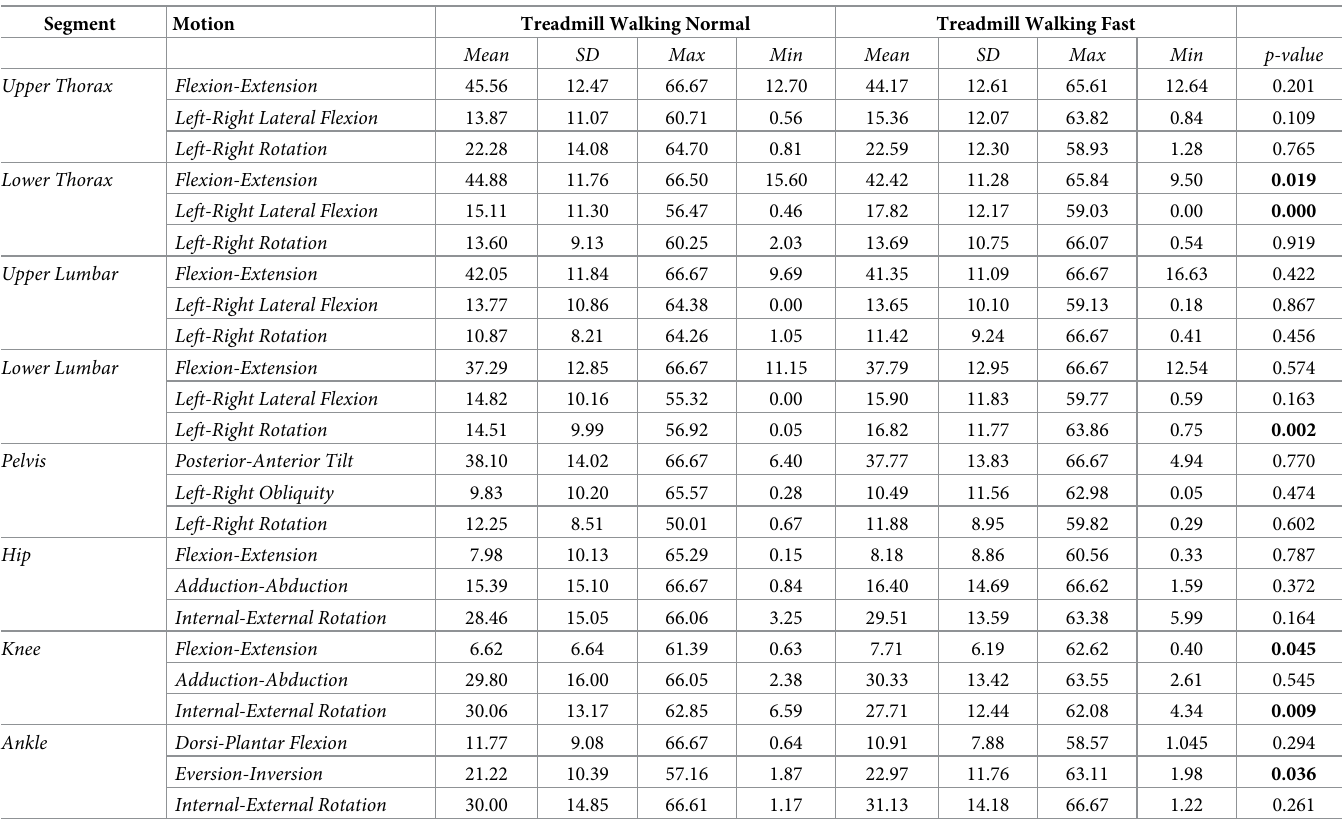
Table 3. Descriptive statistics of the maximum SI norm in % and its comparison between normal and fast treadmill walking for N = 60 participants. Segment Motion Treadmill Walking Normal